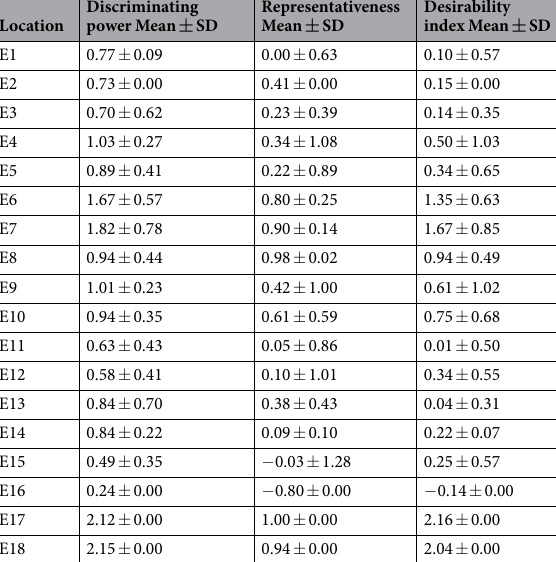
Table 3. Standardized test location evaluation